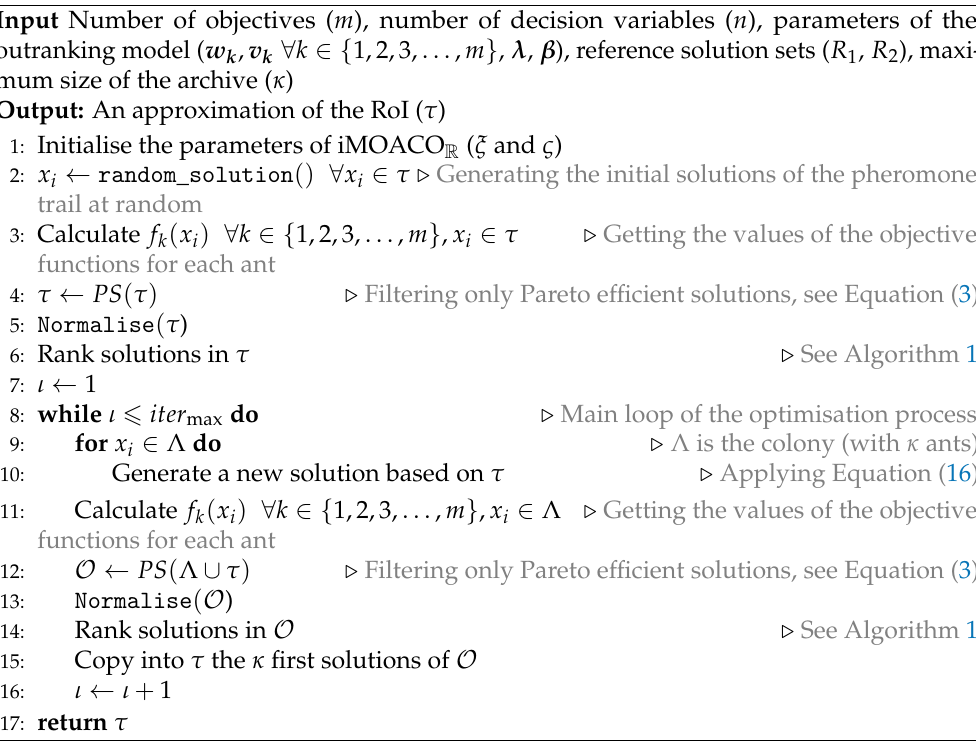
Algorithm 4 Ant Colony Optimisation with Interval outranking-based ordinal